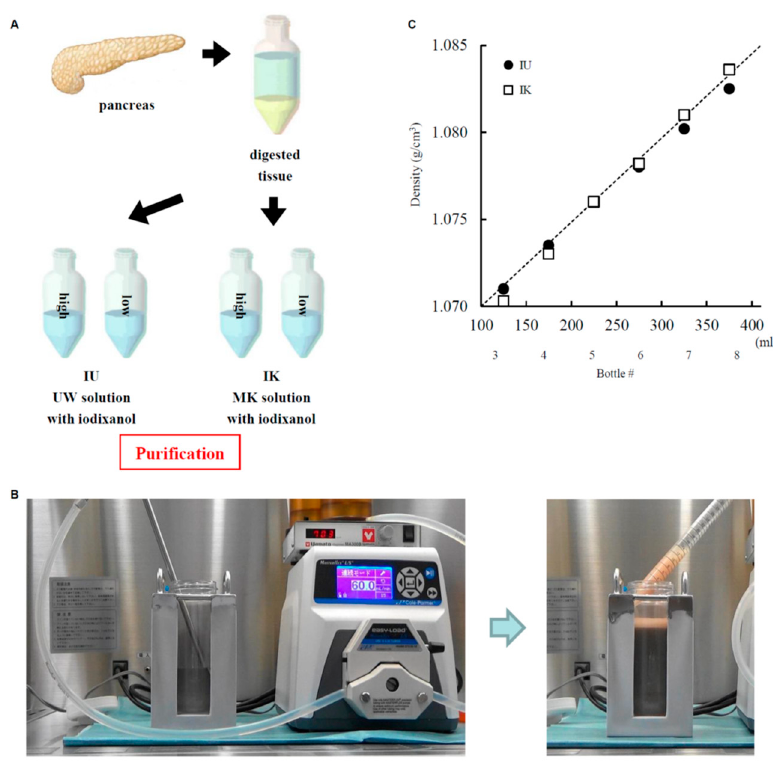
Figure 1. Density of the iodixanol to University of Wisconsin solution (IU) and iodixanol to modified extracellular-type trehalose-containing Kyoto solution (IK) gradients. ( A ) A schematic drawing of the islet purification method. ( B ) Pictures of bottle purification. ( C ) Theoretical density and calculated density of the IU and IK gradients. Dotted line: theoretical density; black circles: calculated density of gradient using IU solution; white squares: calculated density of gradient using IK solution.